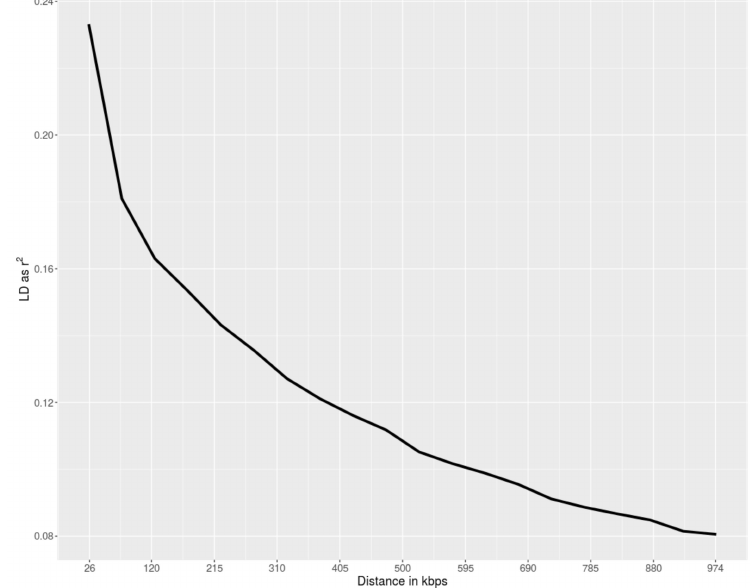
Figure 3. Linkage Disequilibrium decay (measured as r 2 ) as a function of inter-marker distance (Kbp) in the Polverara